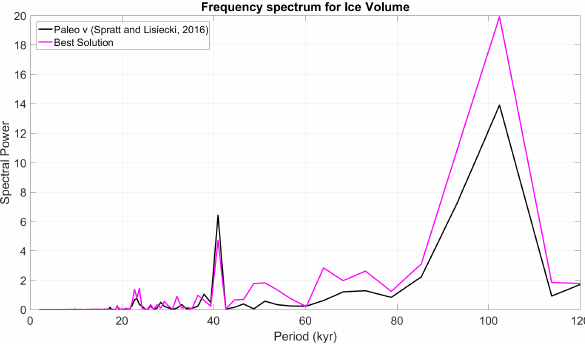
Figure 5. Frequency spectrum for simulated (Best Solution, ma- genta) and reconstructed ice volume (Spratt and Lisiecki, 2016;